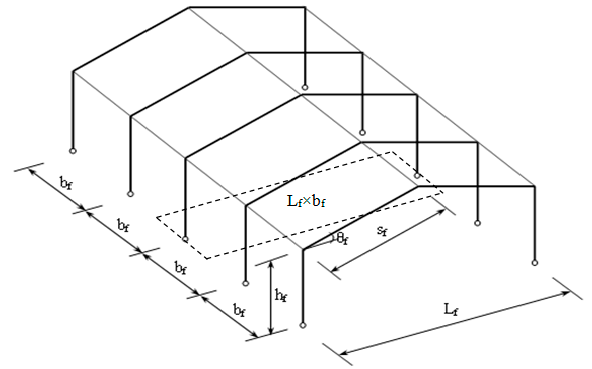
Figure 2. Parameters used to define general portal framing system.